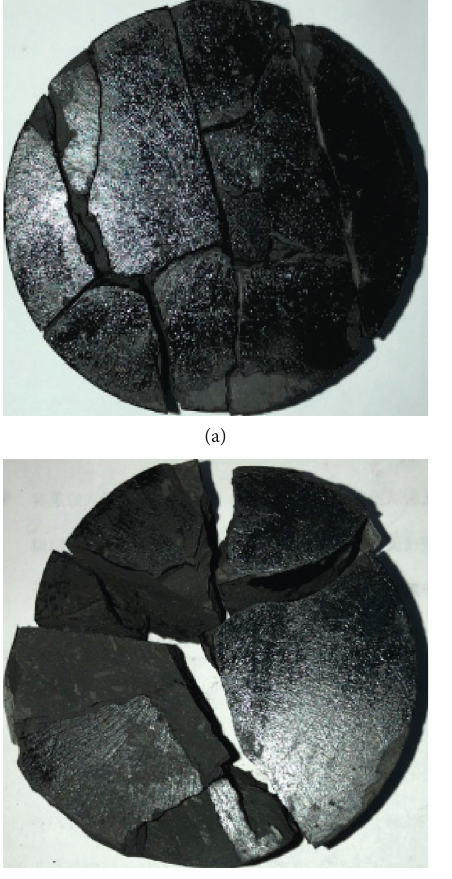
Figure 4: Typical shale rupture morphology: (a) parallel bedding; (b) vertical bedding.